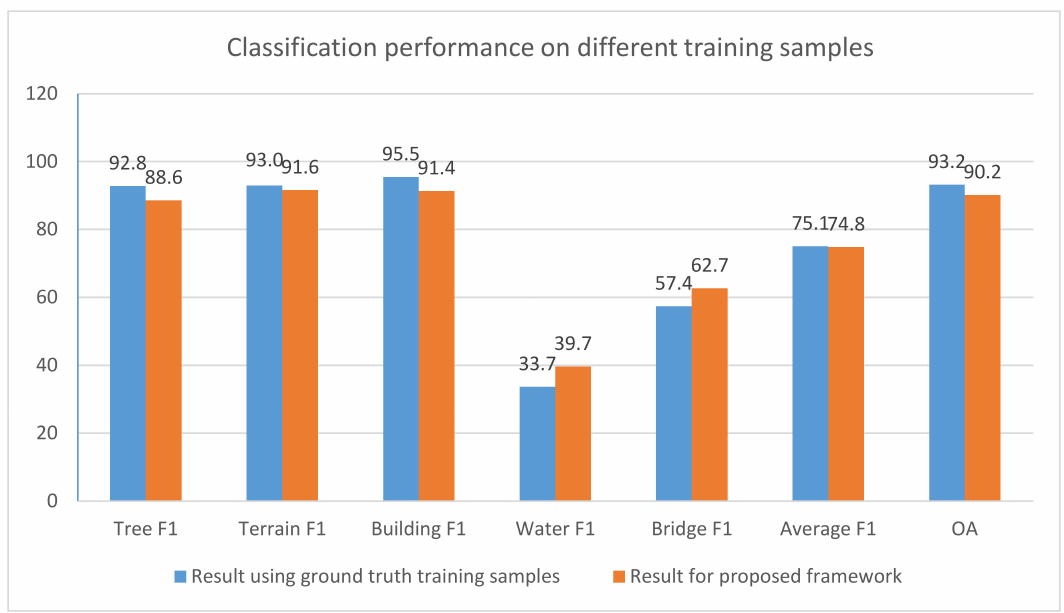
Figure 10. Classification results for the testing area using di ff erent training